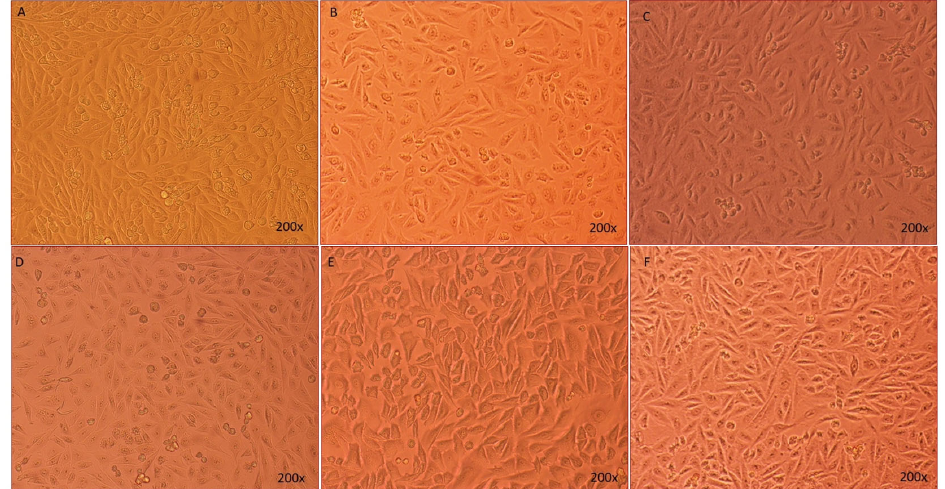
Figure 8. The morphological representation of the HEK ‐ 293 cells taken by light microscope. ( A ) Non Figure 7. The morphological representation of the HEK-293 cells taken by light microscope. treated HEK ‐ 293 cells; ( B – E ) PTZ (0.6 μ g/mL), SVP (120 μ g/mL), BFN (1.50 μ g/mL), THQ (12.0 ( A ) Non treated HEK-293 cells; ( B – E ) PTZ (0.6 µ g/mL), SVP (120 µ g/mL), BFN (1.50 µ g/mL), μ g/mL); ( F ) SVP + BFN + THQ (120 + 1.5 + 12.0 μ g/mL). The cells were first treated with PTZ for 24 THQ (12.0 µ g/mL); ( F ) SVP + BFN + THQ (120 + 1.5 + 12.0 µ g/mL). The cells were first treated h, then were treated with SVP, BFN and THQ and SVP + BFN + THQ for 24 hrs. Magnifications 200×. with PTZ for 24 h, then were treated with SVP, BFN and THQ and SVP + BFN + THQ for 24 h. Magnifications 200 × .